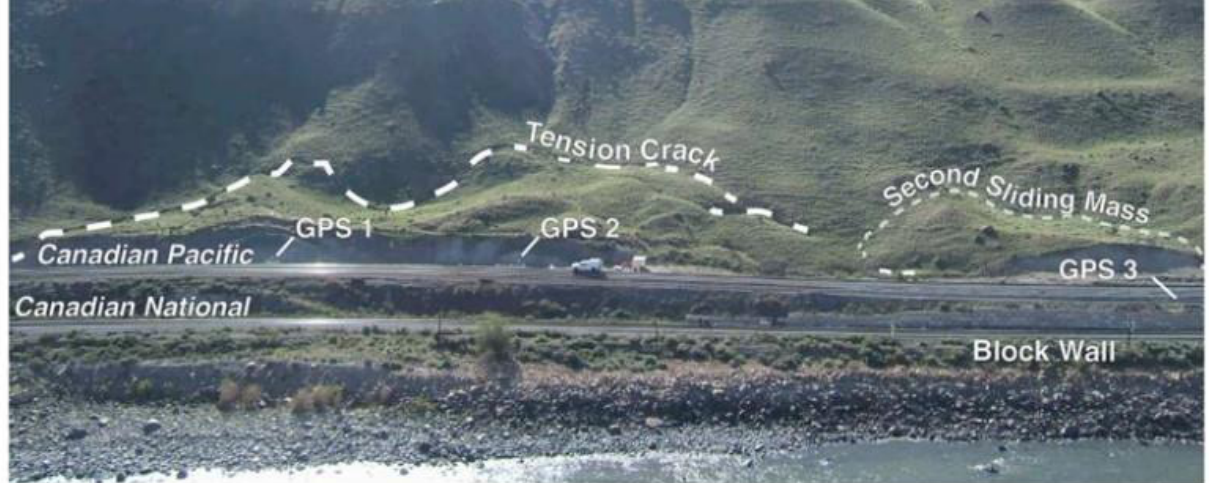
Figure 2. Ripley slide geometry including CN and CP railways and installed GPS on the site.